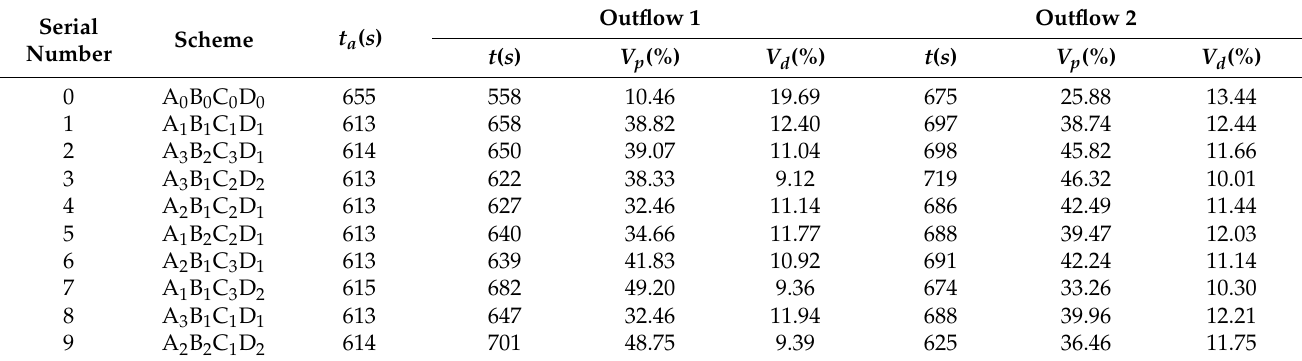
Table 3. Average residence time and dead zone volume fraction of different